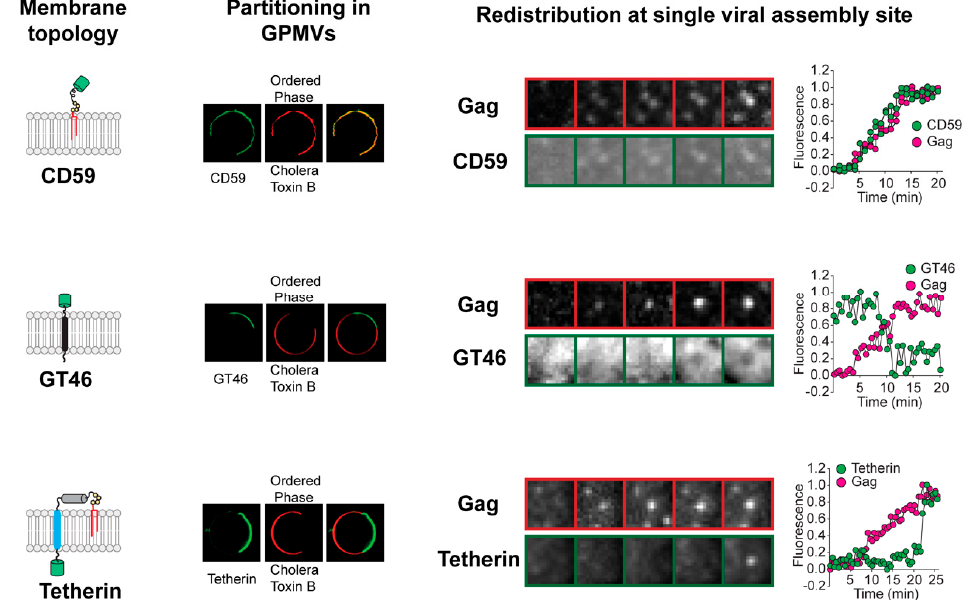
Figure 1. Redistribution of plasma membrane proteins at single viral assembly sites. The kinetics and direction of protein redistribution between the viral assembly site and the bulk plasma membrane are dictated by their affinity for ordered lipid membrane. The lipid phase preference of proteins with distinct membrane-anchoring elements (left column) is revealed by their partitioning between